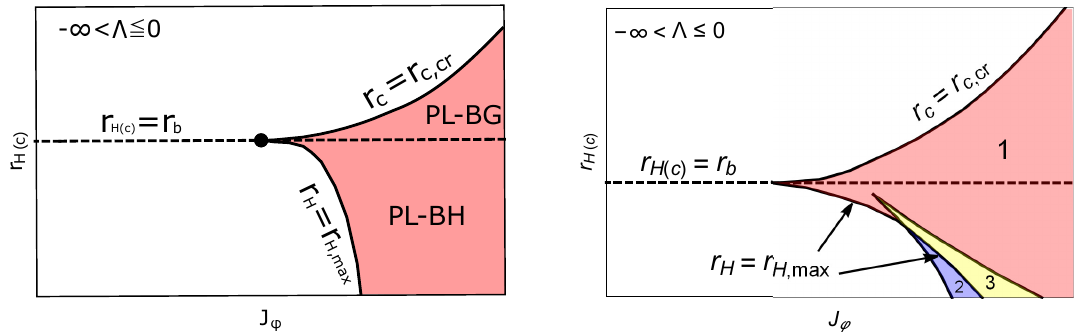
plane of Euclidean PL-soliton, PL-BH, and PL-BG Figure 14 . Existence region on J ϕ − r H ( c ) instanton when Λ ≤ 0 . ( Left ) Simple structure which may appear when both | Λ | /M 2 and r b M are large enough. ( Right ) Complicated structure which appear when the condition does not hold. √ √ (Examples of parameters that exhibit these structures are ( r Λ , M ) = (5 G, − 0 . 04 /G, 0 . 3 / G ) b , √ √ ( Left ) and ( r Λ , M ) = (5 G, − 0 . 004 /G, 0 . 1 / G ) ( Right b ,